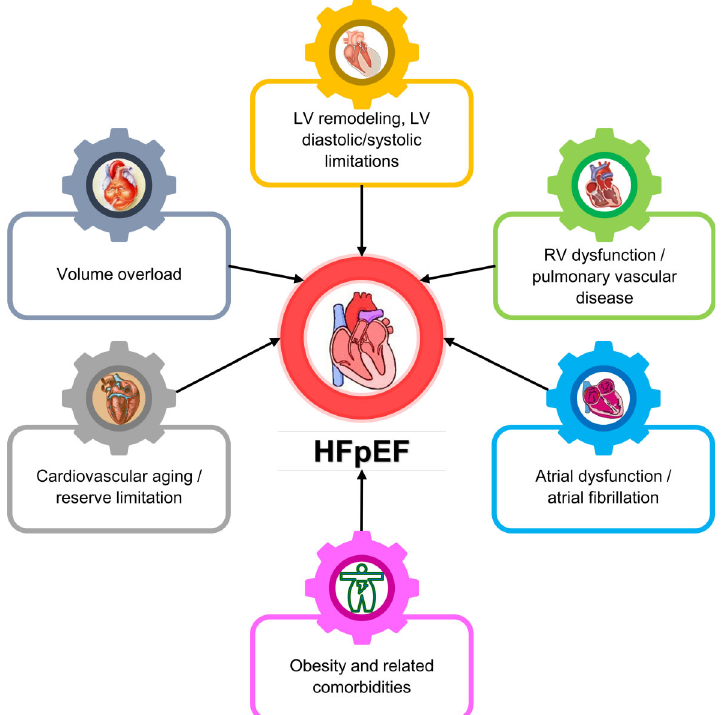
Figure 3. Mechanisms in heart failure with preserved ejection fraction (HFpEF) outlined in this review. LV: left ventricle; RV: right